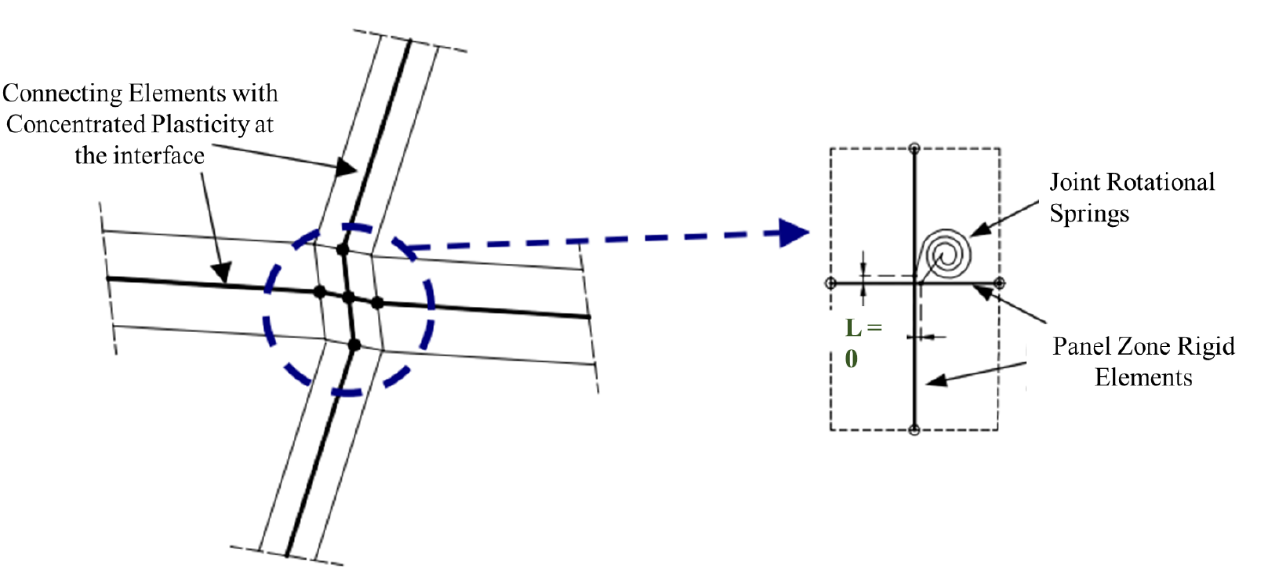
Figure 5. Nonlinear response characterization of rotational springs using a targeted plasticity tech- nique, reproduced from literature [26].